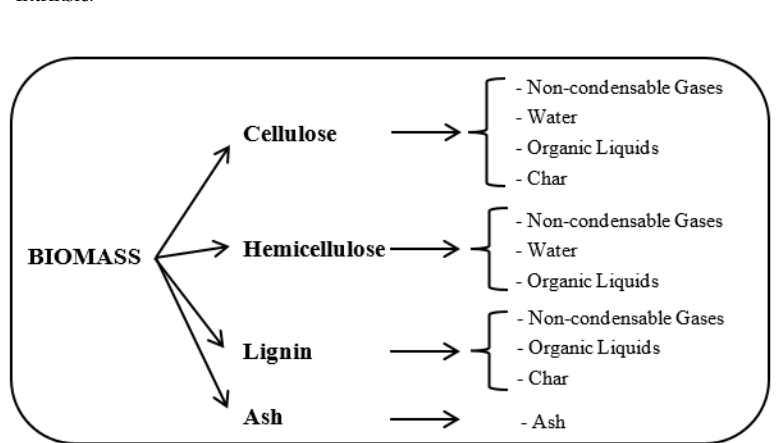
Figure 9. The simplified summary of biomass pyrolysis. Table 4. Biomass constituents (wt.% on a dry basis) [21,29,47] .